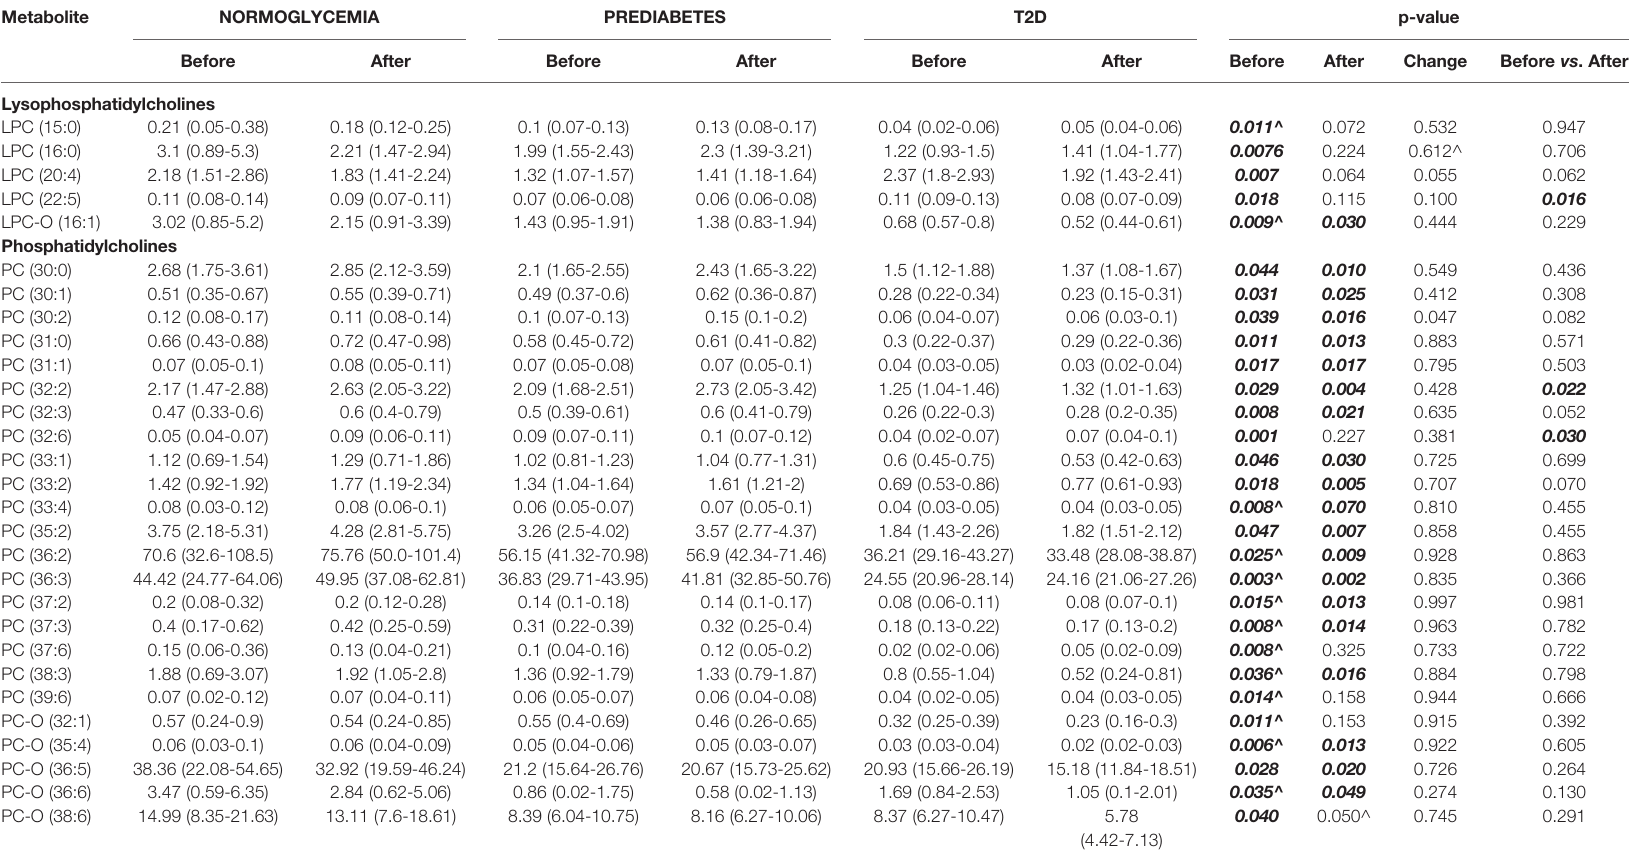
TABLE 3 | Detected signi fi cant differences in measured metabolites from LPC and PC categories, between the experimental groups. Metabolite NORMOGLYCEMIA PREDIABETES T2D p-value Before After Before After Before After Before After Change Before vs . After Lysophosphatidylcholines LPC